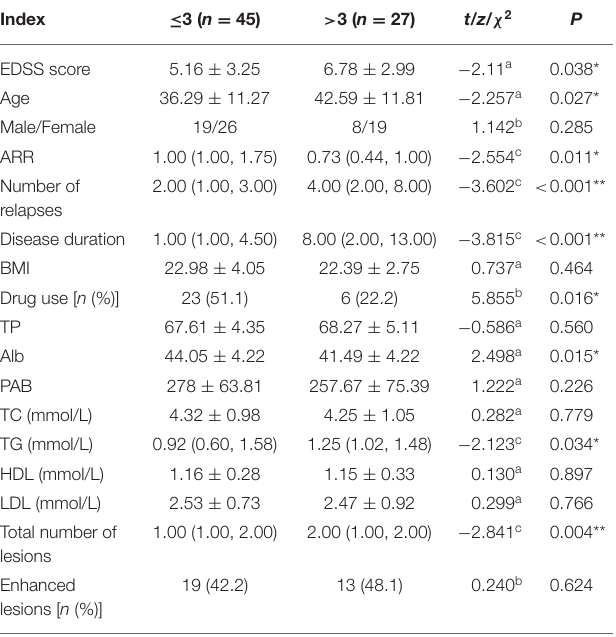
TABLE 1 | Univariate analysis of the degree of disability in MS patients.